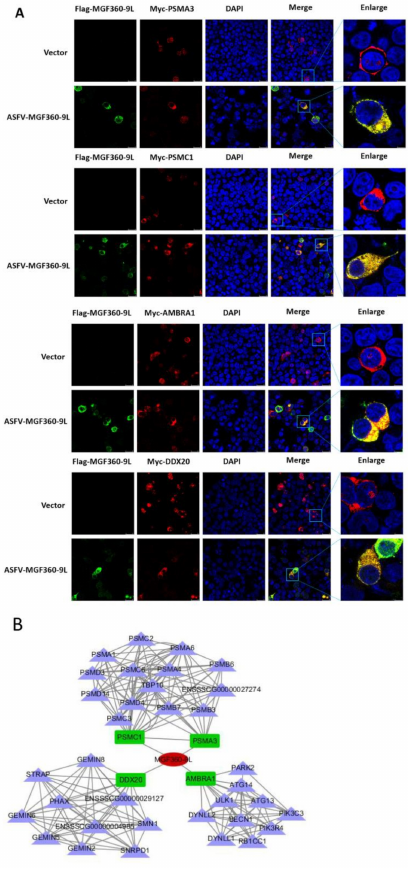
Figure 6. Colocalization of MGF360-9L with PSMA3, PSMC1, AMBRA1, and DDX20. ( A ) HEK- 293T cells were co-transfected with plasmids expressing Myc-PSMA3, Myc-PSMC1, Myc-AMBRA1, or Myc-DDX20 (1 µ g), and plasmids expressing Flag-MGF360-9L (1 µ g). After 24 h, the cells were treated by indirect immunofluorescence and observed by confocal microscope. Among them, the cells were incubated with anti-Flag rabbit mAb and anti-Myc mouse mAb for 8 h. ( B ) MGF360-9L- cellular protein interaction network. Cytoscape v.3.7.1 was used to construct the interaction map between ASFV MGF360-9L protein and interacting cellular protein. The data were tested three times